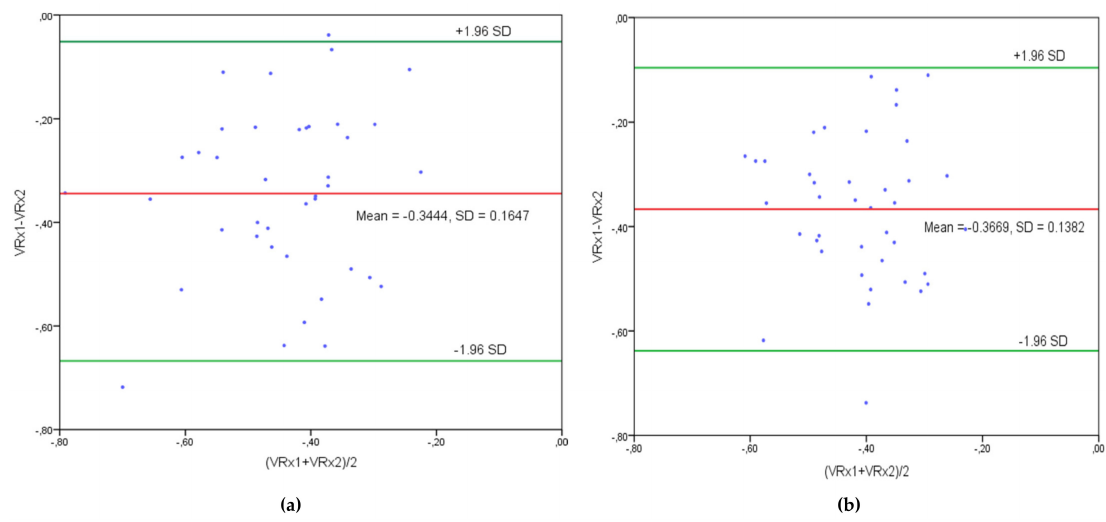
Figure 7. Comparison of VRx1 and VRx2 indices by Bland–Altman plots. ( a ) Bandpass filtering. The standard deviation of the di ff erence between the indices is SD 0.1647. Bias is − 0.3444. ( b ) FIR filtering. The standard deviation of the di ff erence between the indices is SD 0.1382. Bias is −